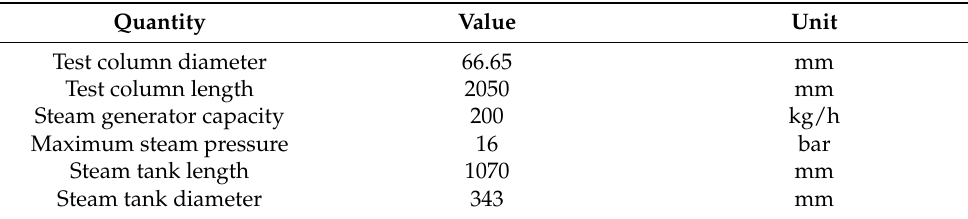
Table 6. The test rig equipment in [41].